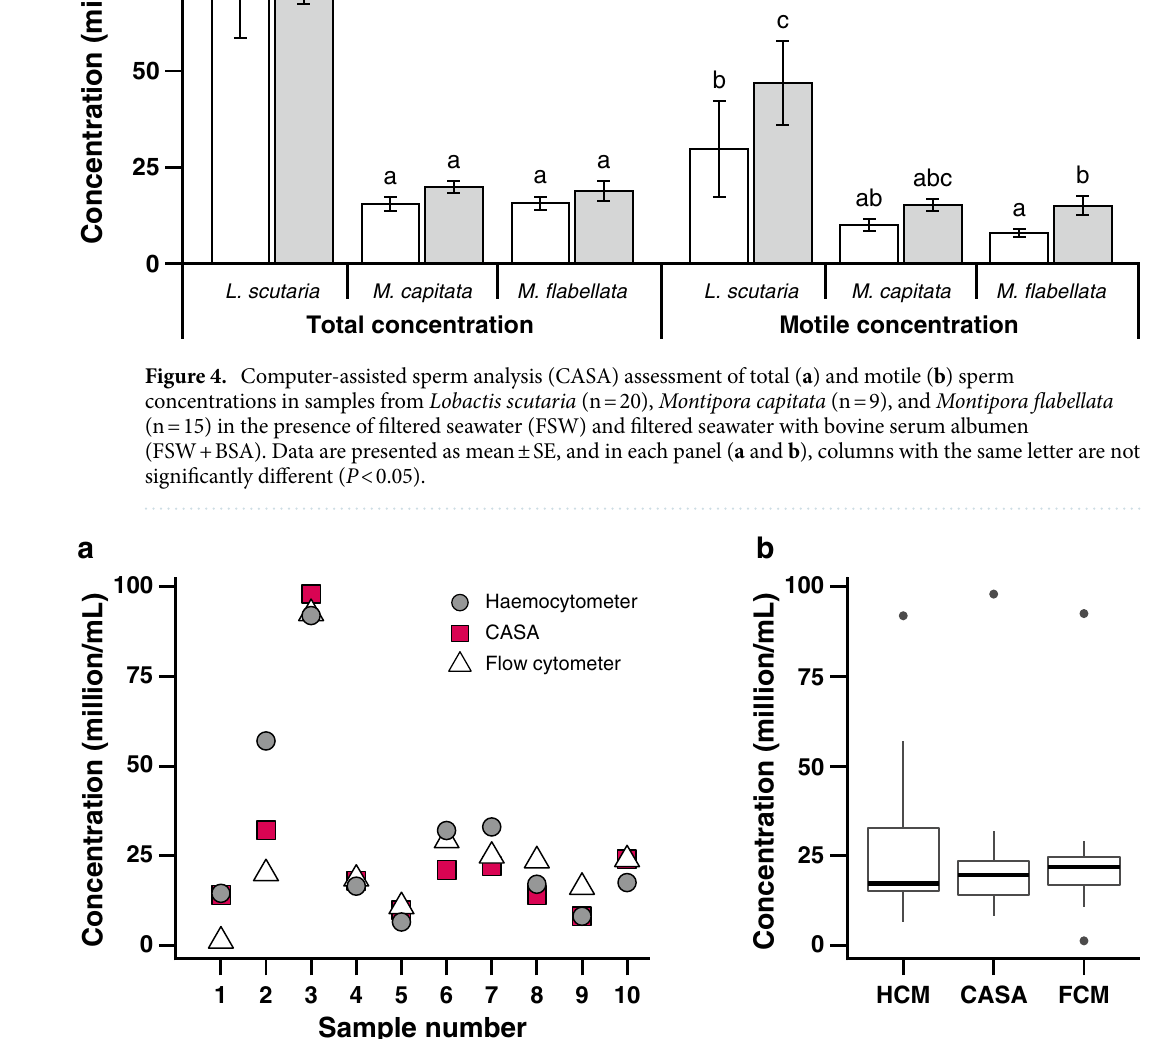
Figure 5. Sperm concentration in Lobactis scutaria samples (n = 10) measured using haemocytometer (HCM), computer-assisted sperm analysis (CASA), and flow cytometer (FCM). Data are presented individually ( a ) and as a box and whisker plot ( b ) showing median, sample range, and outliers (dots) for each assessment